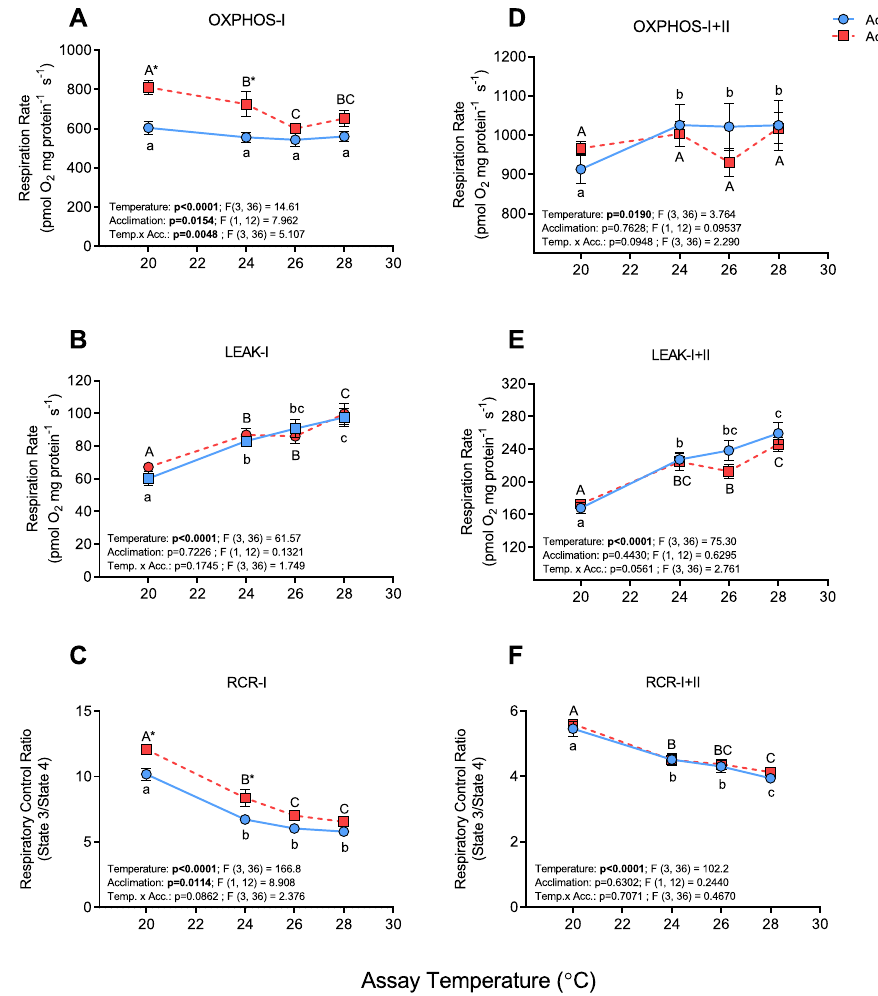
Figure 1. Respiration and respiratory control ratio (RCR) in cardiac mitochondria from cold- (12 °C) and warm- (20 °C) acclimated salmon when measured at 20, 24, 26 and 28 °C. Oxidative phosphorylation (OXPHOS